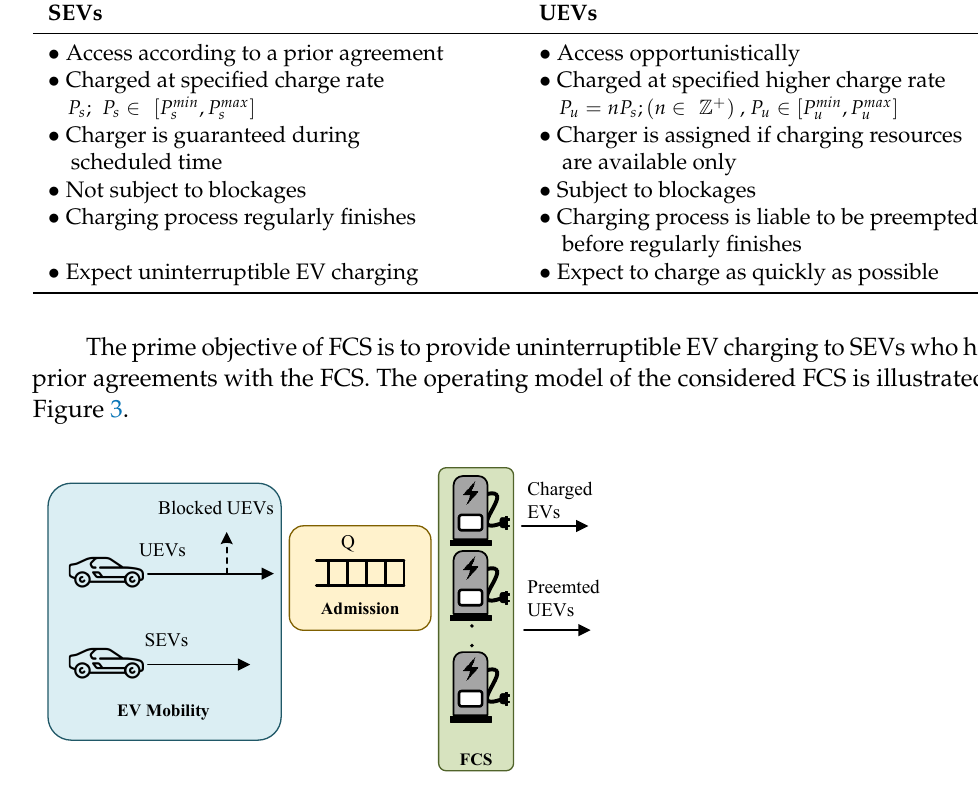
Figure 3. Proposed operation mechanism of the FCS